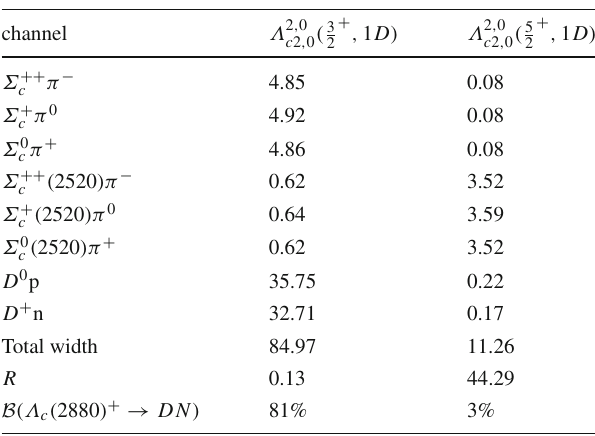
+ , ( 3 1 D ) and c 2 , 0 2